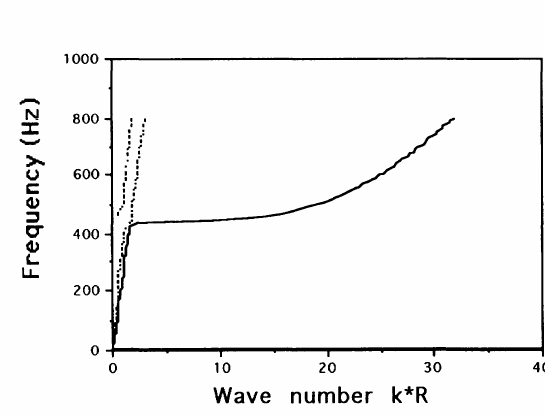
FIGURE 7 Dispersion relation for cylindrical shell (steel, R = 2 m, t = 0.01 m, n = 0). The resonances are at discrete values of the dimensionless wave num ber k*R. For a length L = 10 and simply supported ends, these are close to every integer value of k*R. The abrupt kink in the lower branch occurs near the ring extensional frequency fE' Slightly above this there are around 10 resonances, or eigenfrequencies, at close to the same value that correspond to mode shapes similar to that in Fig. 4, i.e., with short wavelength. The higher branches give a number of resonances at high frequencies that correspond to long wavelength axial and shear modes. Each of the low circumferential harmonics has a similar behavior. In total there are around 100 eigenfrequencies close to the ring exten sional